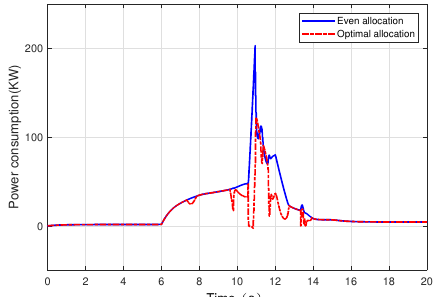
Figure 8. Comparison of power